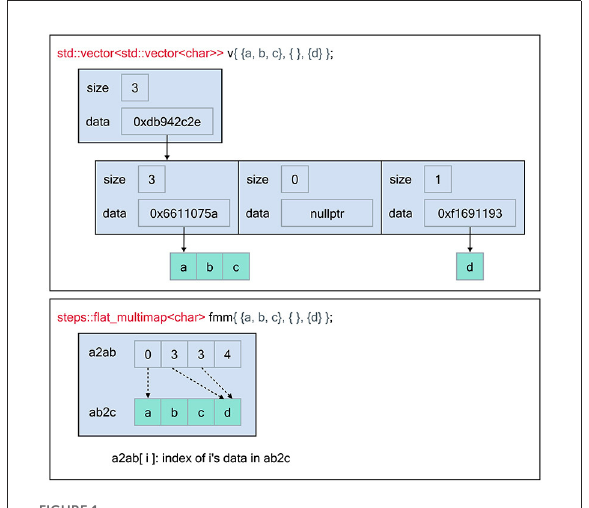
FIGURE1 Memory layout of the flat-multimap container in comparison with a vector of vectors container constructed using the Standard Template Library to store the following key-values: 0 → [a, b, c], 2 → [d] . The flat-multimap class relies on 2 member variables, a2ab and ab2c . a is the top element index, ab is an index to retrieve the data of a in ab2c . Data are stored contiguously in flat-multimap to reduce heap fragmentation and increase data locality. In contrast, data